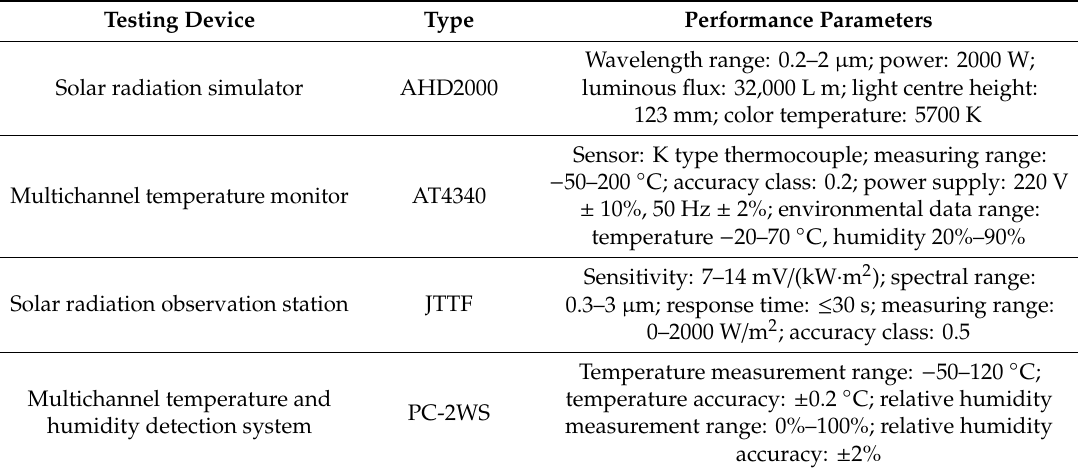
Table 1. Performance parameters of the testing devices.